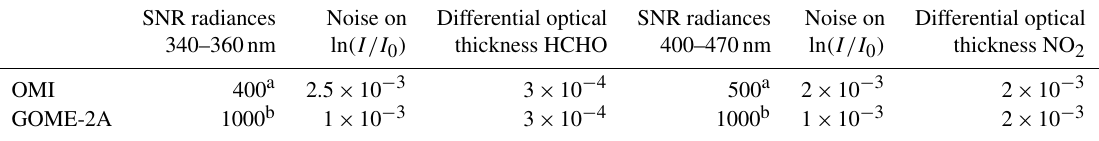
a Based on globally averaged OMI level 1 radiance SNR levels recorded for orbit 21078 (1 July 2008) (Quintus Kleipool, personal communication, 2017). The SNRs in the OMI irradiance (reference spectra used for retrievals, e.g. yearly averages in the OMNO2A v1, v2 approach) are much higher, 2000 for UV2 and 4000 for VIS, that it is neglected in the calculation of the uncertainty of the logarithm of the reflectance. b This estimate (for 2007) is based on the level 1 radiance levels mentioned in the Table caption and signal-to-noise vs. level 1 curves for GOME-2A Band 4 and Band 5 obtained from Ruediger Lang (personal communication,